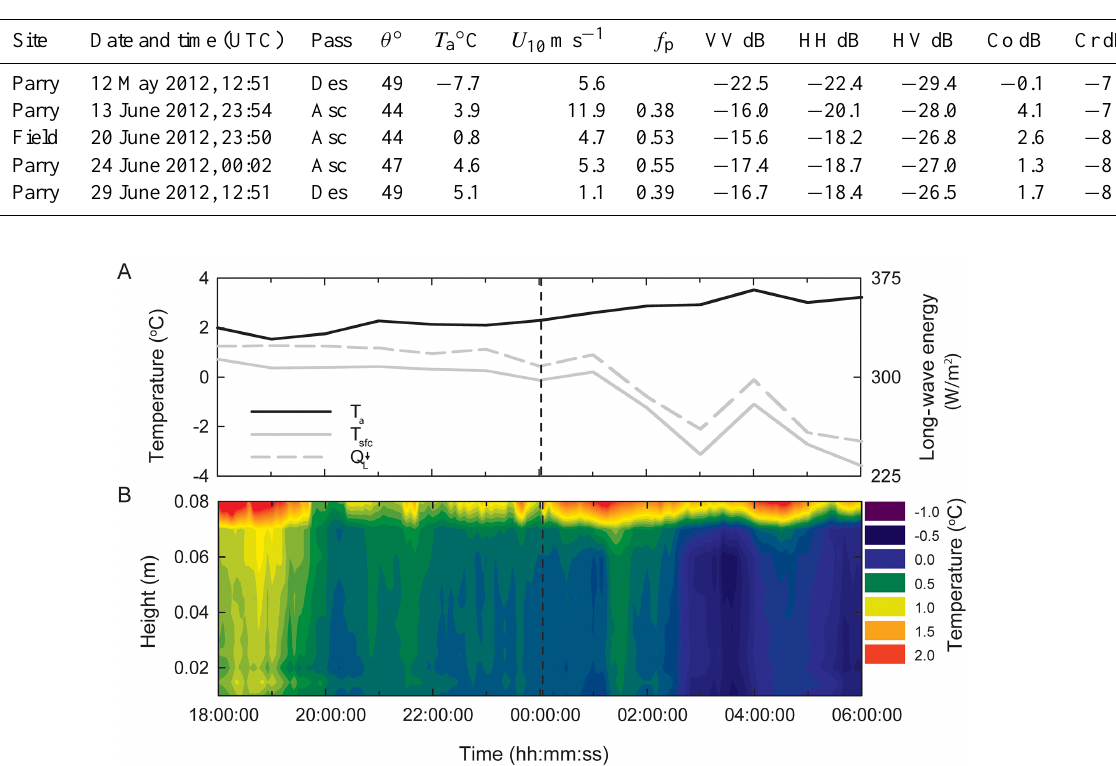
Figure 4. Meteorological variables and melt pond water temperature profile from 23 June 2012, 18:00:00UTC to 24 June 2012, 06:00:00UTC at the Field site, with the time of the R4 acquisition and coincident AP survey indicated by dashed vertical lines. (a) 1m air temperature ( T a ) , surface temperature ( T sfc ) , and downwelling long-wave radiation ( Q pond water level was recorded as 0.085m before, and 0.075m after, the time series. The absolute position of the air–water interface